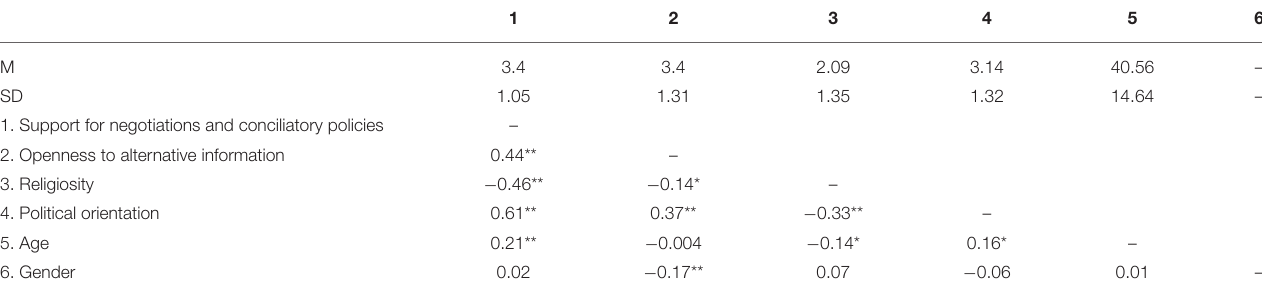
TABLE 3 | Means, SDs, and bivariate correlations among Study 2